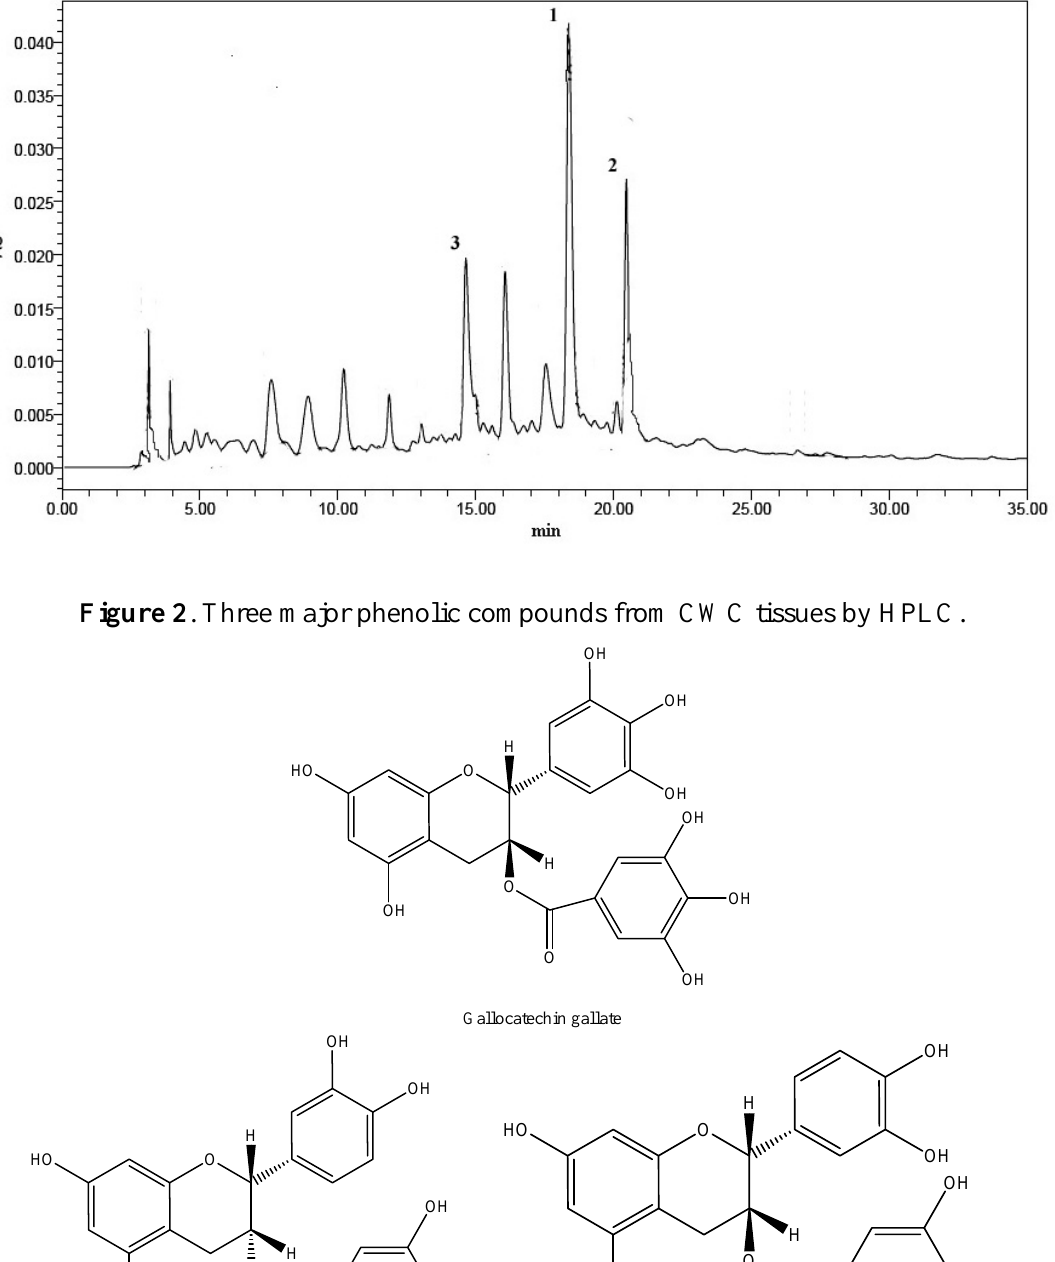
Figure 1. HPLC profile of CWC extract at 280 nm. Peak 1: (–)-gallocatechin gallate; peak 2: (–)-epicatechin gallate and peak 3: (+)-catechin gallate.